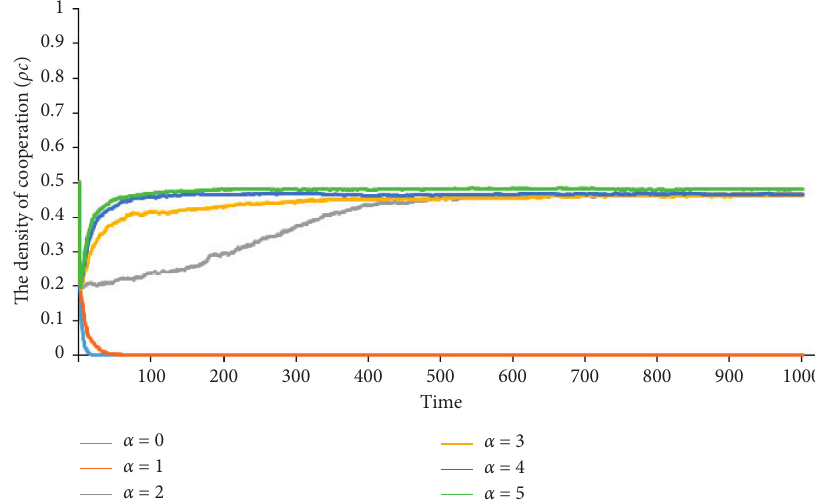
Figure 8: Time course of the density of cooperation for different values of α , the depicted is obtained in SDG for u � 0 and r � 0.8. It is observed that the density of cooperation will rise with the increase of α